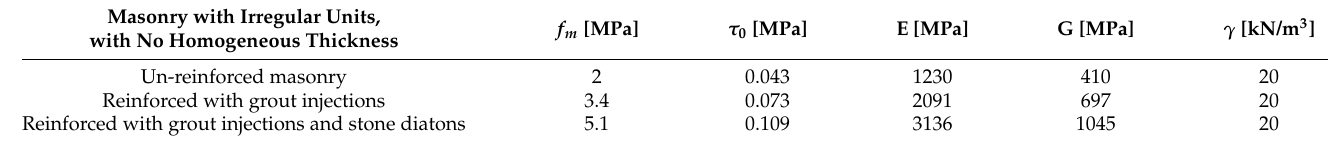
Table 3. Mechanical parameters of the